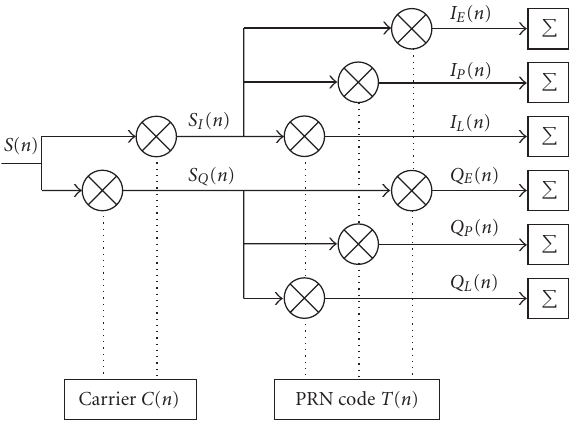
Figure 1: Standard base-band GPS architecture.